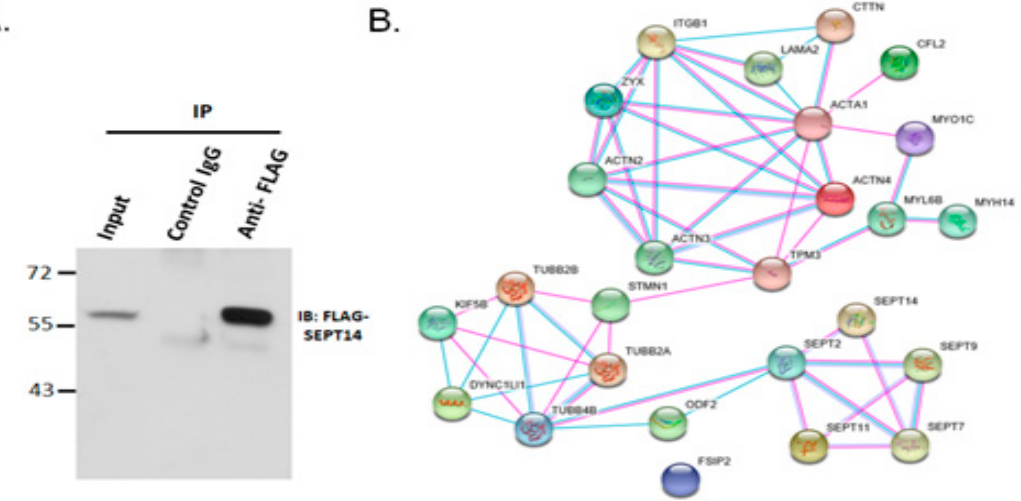
Figure 2. Identification of SEPT14 interactors through co-IP and nano-LC-MS / MS. ( A ) Co-IP analysis of lysates from cells transfected with the pFLAG-SEPT14 plasmid. Lysates were immunoprecipitated with either a nonspecific immunoglobulin G (IgG) control (control IgG) or FLAG antibody (Anti-FLAG). Input protein (5%) was used as an IB control (input). IB revealed a FLAG-SEPT14 signal. The transfected cells have been performed Co-IP and nano- LCMS / MS, triplicate. ( B ) Clustering of SEPT14 interactors. The interaction network of SEPT14 interactors includes (1) SEPT-, (2) actin-, (3) microtubules-, and (4) sperm structure-related proteins, and was generated using STRING software. Green and pink lines indicate interactions elucidated from the previous curated database and the current experimental analysis, respectively.